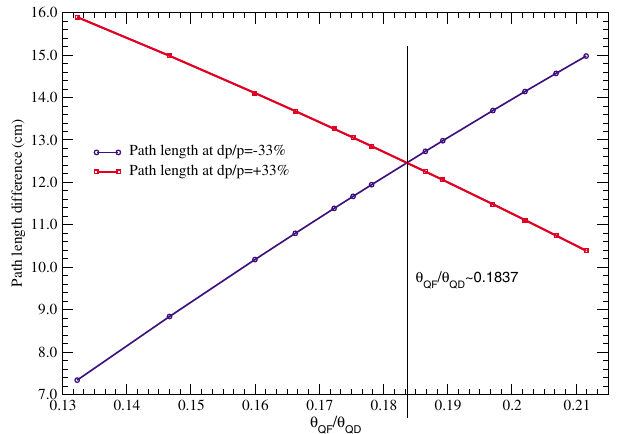
FIG. 14. (Color) Opposite bend vs major bend for equalizing the parabola.